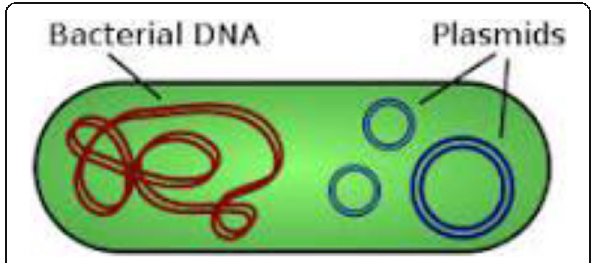
Fig. 4 Diagram of the endospore of Bt (from